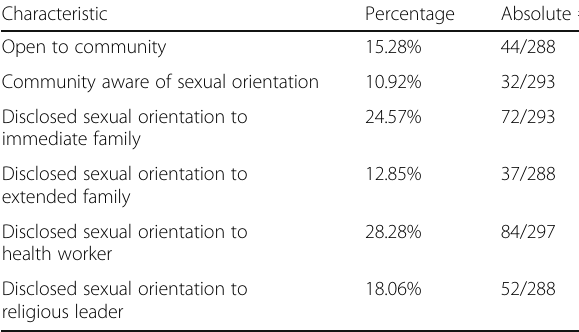
Table 2 Disclosure of sexual orientation among MSM in